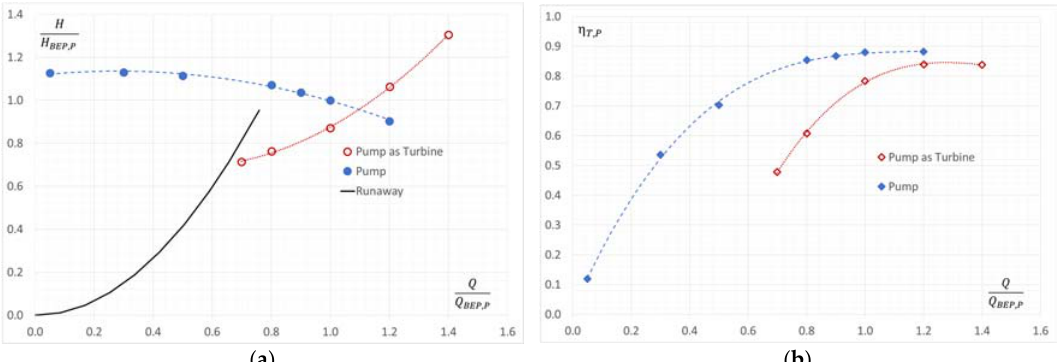
Figure 3. Plot of the hydraulic turbo machine performance in both pump and turbine operating modes: ( a ) Head curves calculated with Equation (4) with runaway curve; ( b ) Efficiency calculated with Equation (5).